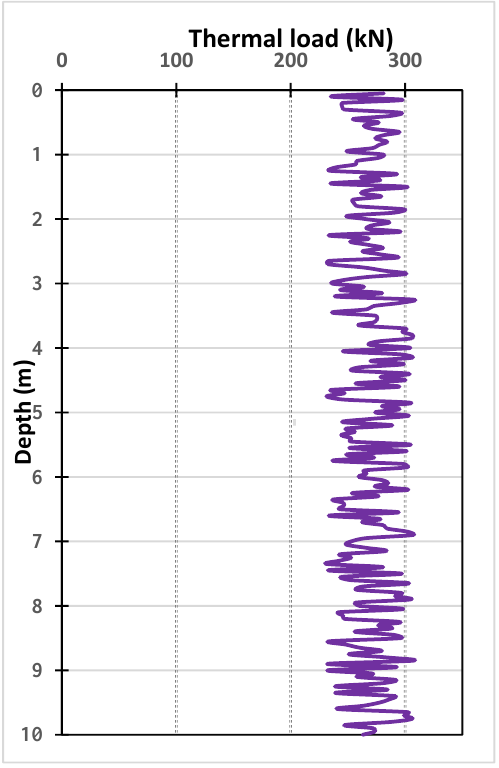
Figure 7. Variation of thermal load ( kN ) with depth ( m ) of soil.